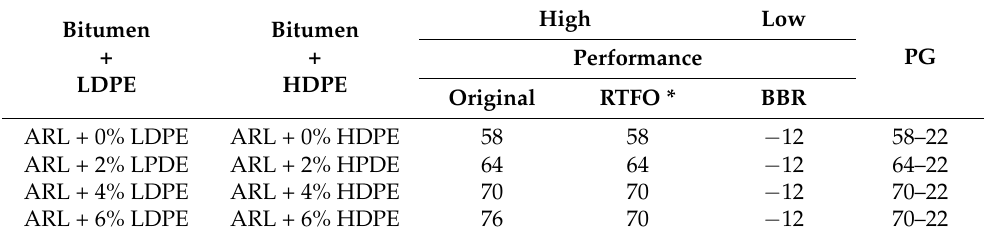
Table 3. Low- and high-performance grade testing of HDPE and LDPE modified